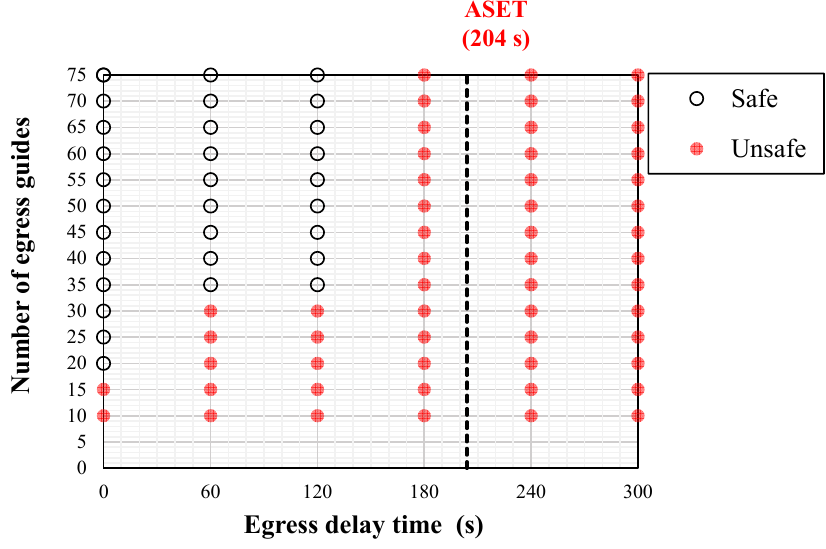
Figure 10. Egress safety evaluation of prototype nursing hospital.